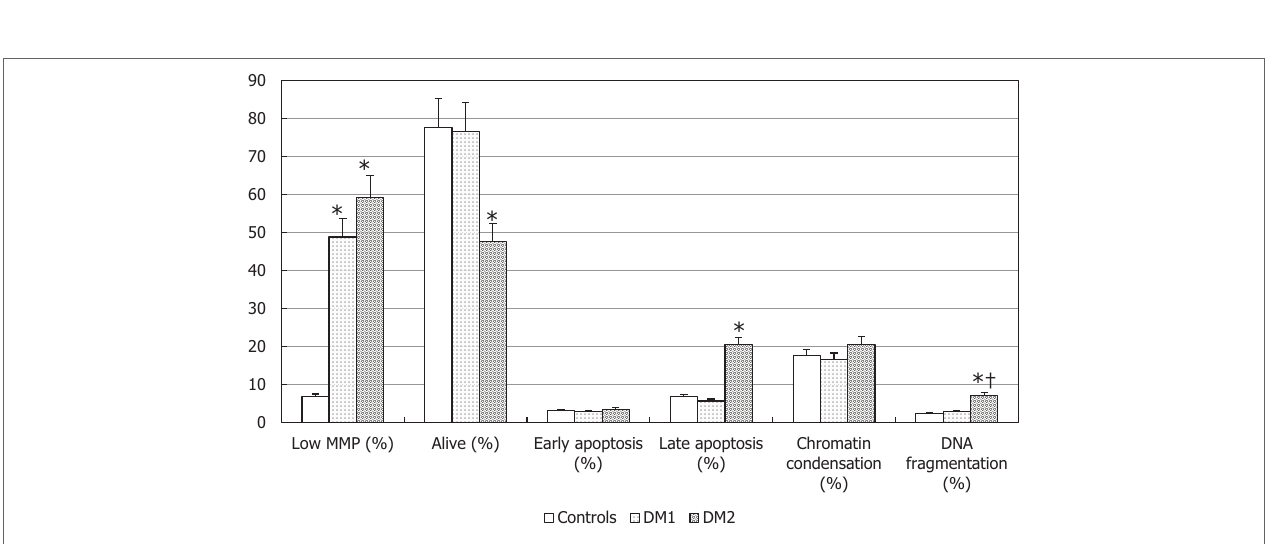
FigUre 2 | Dot plot related to flow cytometric evaluation of mitochondrial membrane potential in a control, in a patient with type 1 diabetes mellitus (DM1), and in a patient with type 2 diabetes mellitus (DM2) (a) . Dot plot related to flow cytometric evaluation of vitality/apoptosis in a control, in a DM1 patient and in a DM2 patient (b) . Dot plot related to DNA fragmentation, with negative control (NC), for threshold-setting method, in a control, in a patient with DM1, and in a patient with DM2 (c)